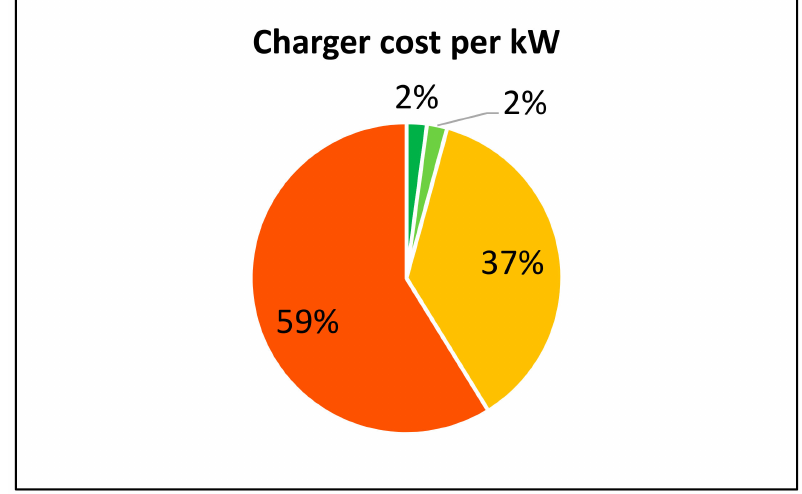
Figure 22. Satisfaction of charger cost per